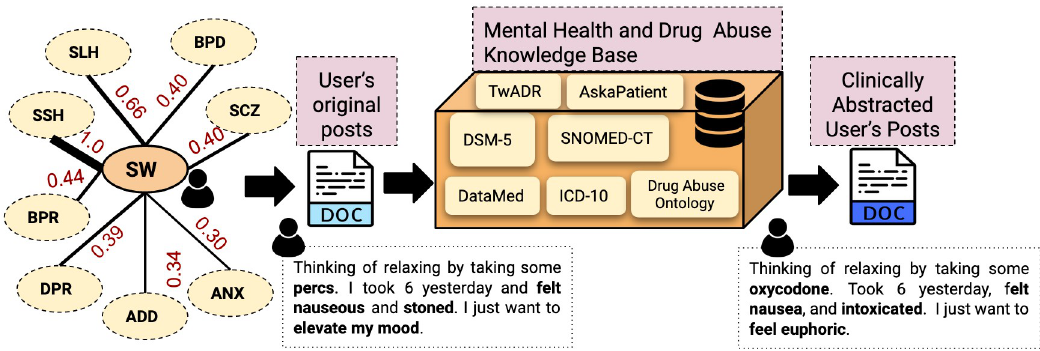
Fig 4. The transient posting of potential suicidal users in other subreddits requires careful consideration to appropriately predict their suicidality. Hence, we analyze their content by harnessing their network and bringing their content if it overlaps with other users within r/SuicideWatch (SW). We found, Stop Self Harm (SSH) > Self Harm (SLH) > Bipolar (BPR) > Borderline Personality Disorder (BPD) > Schizophrenia (SCZ) > Depression (DPR) > Addiction (ADD) > Anxiety (ANX) (User overlap between SW and other MH-Reddit is shown by thickness in the connecting line) to be the most active subreddits for suicidal users. After aggregating their content, we performed MedNorm using Lexicons to generate clinically abstracted content for effective